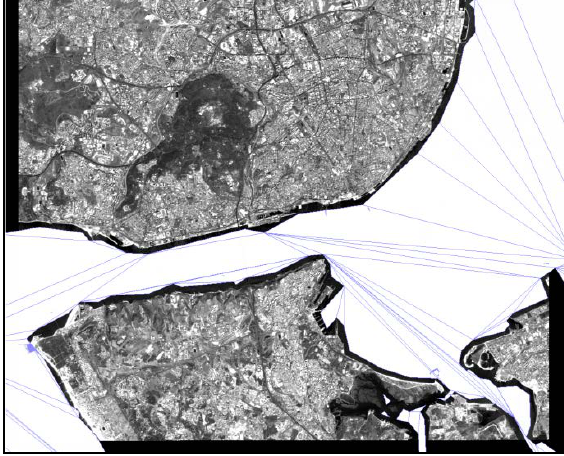
Figure 2: Dilated water mask generated from SRTM. The simplified water polygons are drawn white with blue edges.